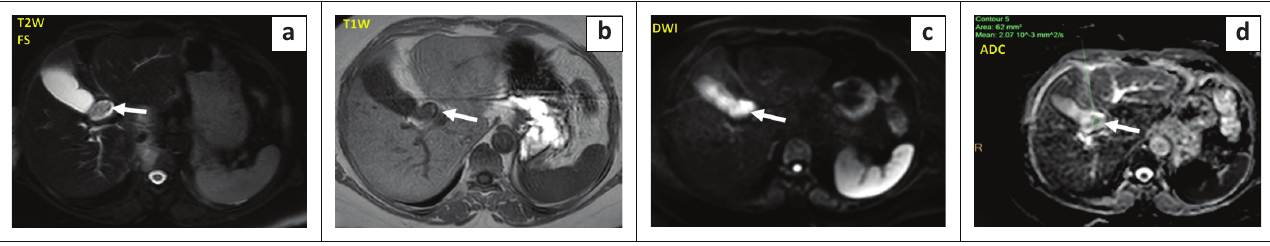
FIGURE 2: Axial T2W–TSE (a) and T1-FFE (b) sections demonstrating an iso to hypointense mural-based growth (white arrow) projecting into the lumen of the common hepatic duct or CBD. High signal is observed within the lesion on the axial b-1000 DWI image (c) with low signal on the corresponding ADC map (d).